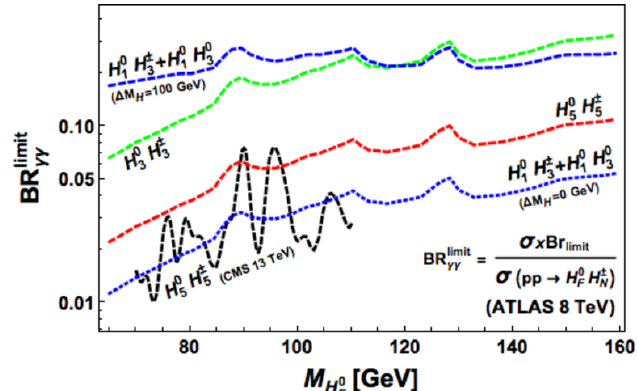
Figure 1 . The dashed colored lines show the allowed branching ratio by 8 TeV ATLAS diphoton searches [37] with 20 : 3 fb (cid:0) 1 of data (65 (cid:0) 160 GeV) as a function of mass for a custodial fermiophobic Higgs boson produced dominantly via the Drell-Yan pp ! W (cid:6) ! H 0 H (cid:6) Higgs pair production F N channel. The custodial singlet ( H 0 ), triplet ( H 0 ), and (cid:12)veplet ( H 0 ) cases are shown with couplings 1 3 5 de(cid:12)ned in eq. (2.1). For the range 70 (cid:0) 110 GeV, we also show (black dashed) the more recent 13 TeV CMS low mass diphoton search [38] which has a (cid:24) 3 (cid:27) excess at (cid:24) 95 GeV with 35 : 9 fb (cid:0) 1 of